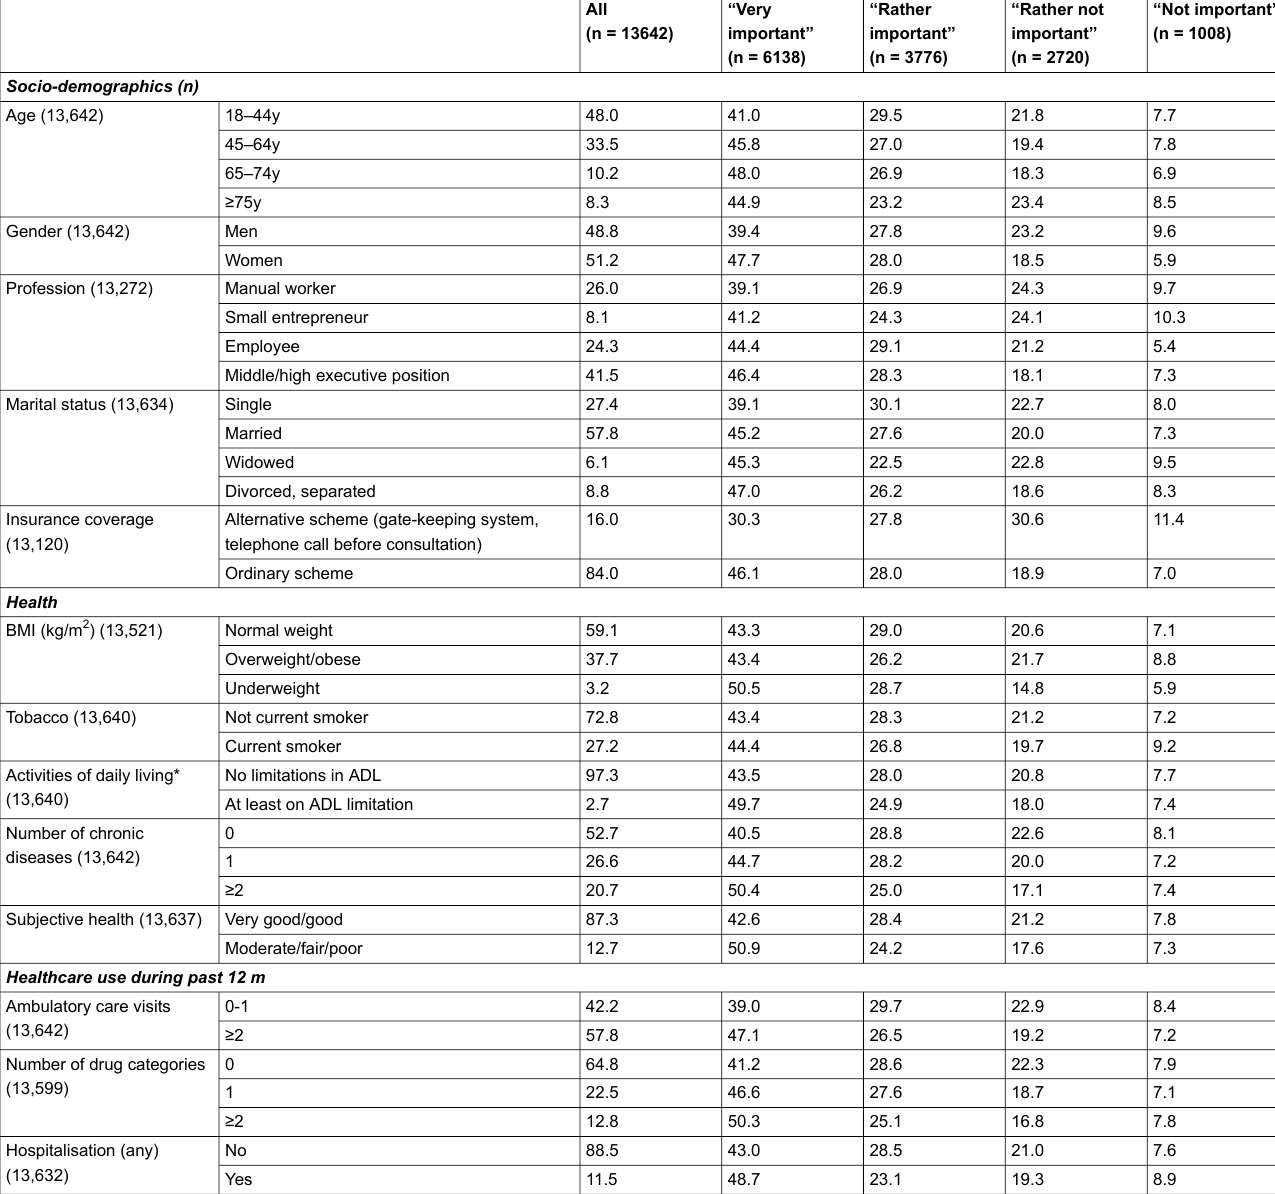
Table 1: Characteristics of participants (Swiss Health Survey 2007, weighted results) and proportion of participants in each category of response, by level of covariate, %.